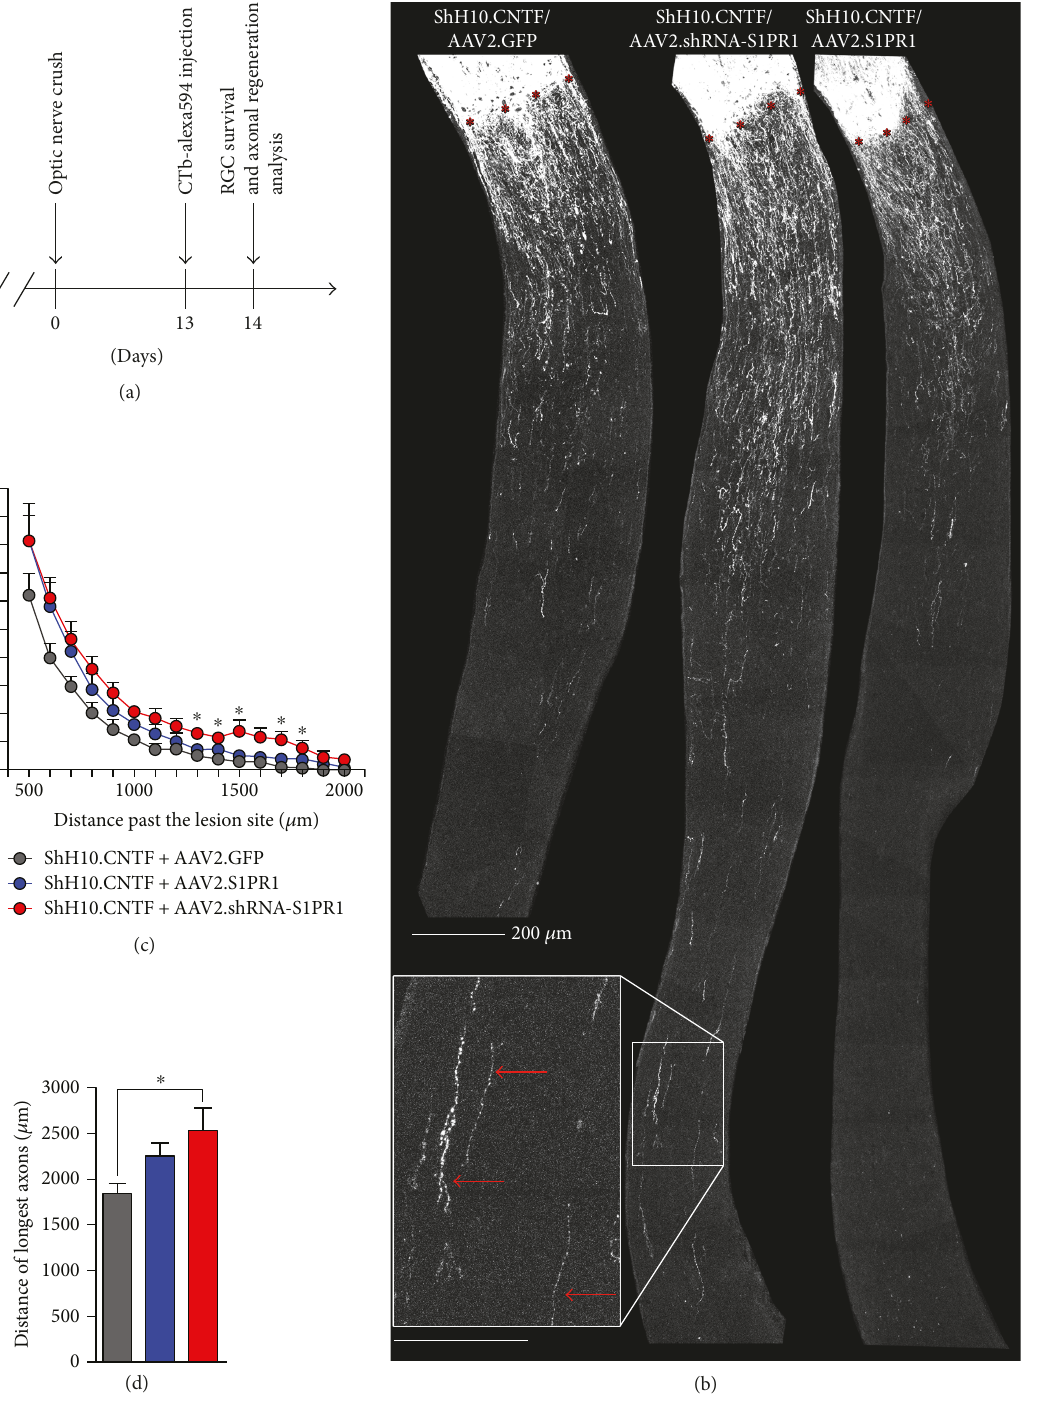
Figure 2: S1PR1 knockdown potentiates CNTF-induced axonal regeneration. (a) Axonal regeneration was visualized on longitudinal sections of optic nerves two weeks after crush injury and 4 weeks after coinfection with ShH10.CNTF and AAV2 vectors. Axons were traced with cholera toxin β subunit (CTb) conjugated to Alexa 594 the day before tissue fi xation. (b) The infection of retinal cells with ShH10.CNTF and AAV2.shRNA-S1PR1 promoted lengthy axonal regeneration in the optic nerve compared with the ShH10.CNTF/AAV2.GFP combination. (c) Quantitatively, axonal fi bers were signi fi cantly more numerous between 1300 and 1800 μ m past the lesion site with ShH10.CNTF/AAV2.shRNA-S1PR1 ( n = 6 mice) than with ShH10.CNTF/AAV2.GFP ( n = 5 mice) treatments (ANOVA, ∗ p < 0 05 ). ShH10.CNTF/AAV2.S1PR1 did not in fl uence axonal regeneration ( n = 6 mice). (d) The measurement of the longest axons revealed better growth distances in ShH10.CNTF-/AAV2.shRNA-S1PR1-treated animals than in mice receiving ShH10.CNTF/AAV2.GFP. Scale bars: (b) top=200 μ m; (b) bottom=100 μ